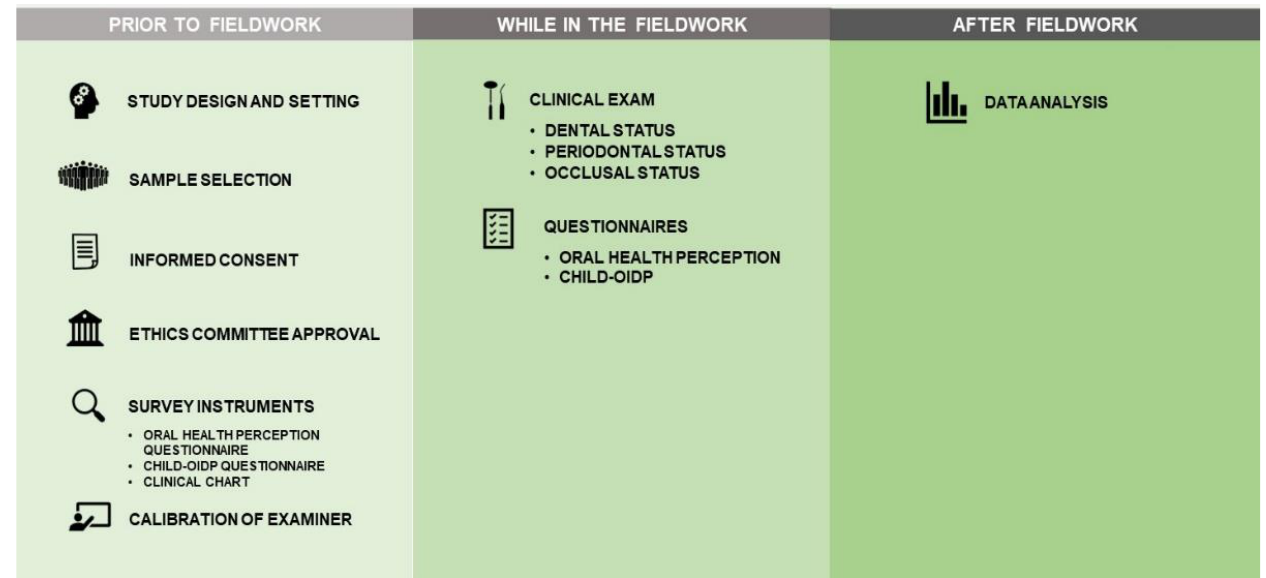
Figure 1. Graphical illustration of the methodology followed in the study.